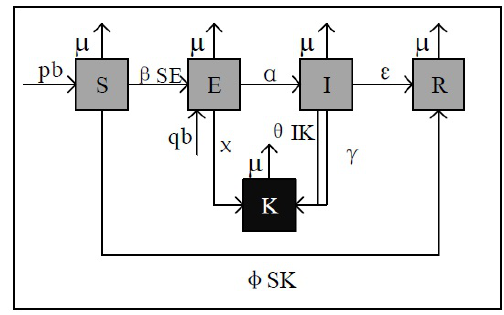
Fig. 2 SEIR-KS computer virus propagation model. KS, killer